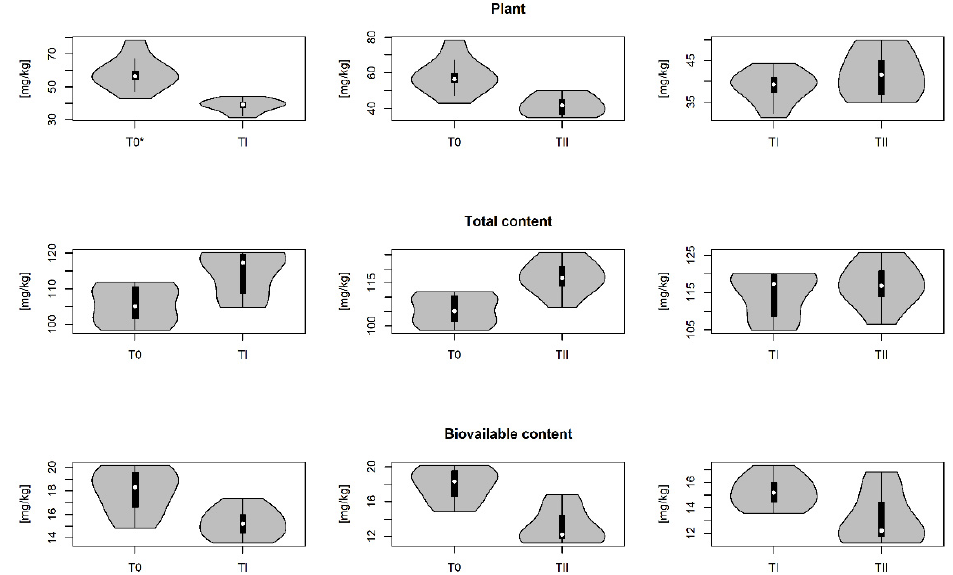
Figure 7. Zn contents in oat and soil (total and bioavailable amounts); * for descriptions see Material and Methods. Statistically significant differences and p -value are presented in Table 3.